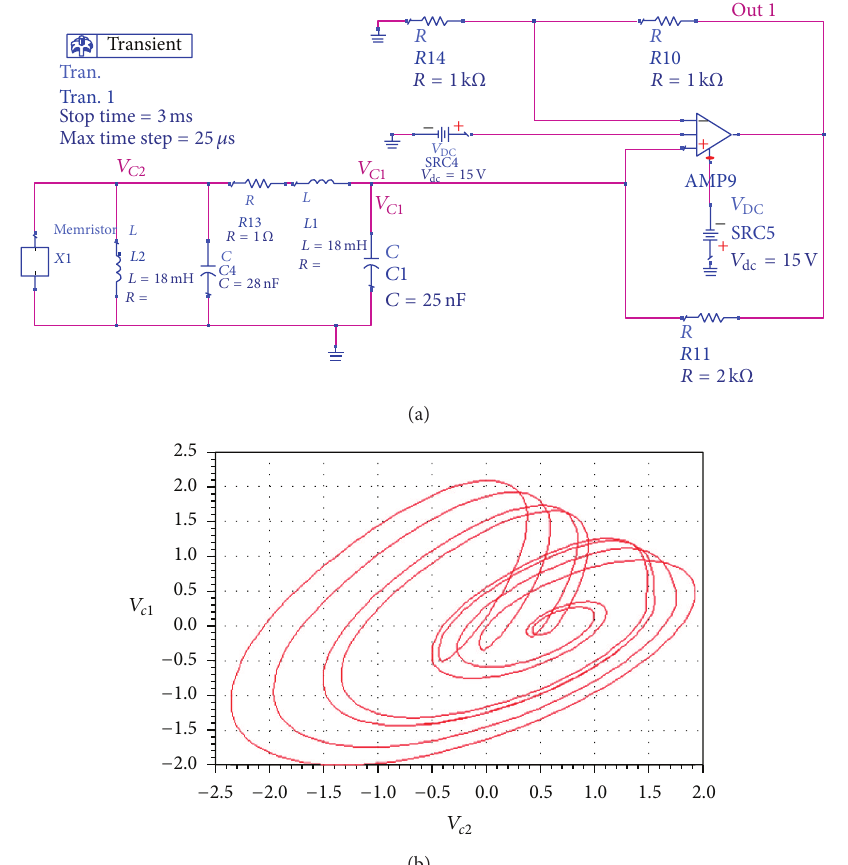
Figure 10: (a) ADS implementation of chaotic oscillator based on memristor; (b) phase plane 𝑉 𝑐1 versus 𝑉 𝑐2 from ADS